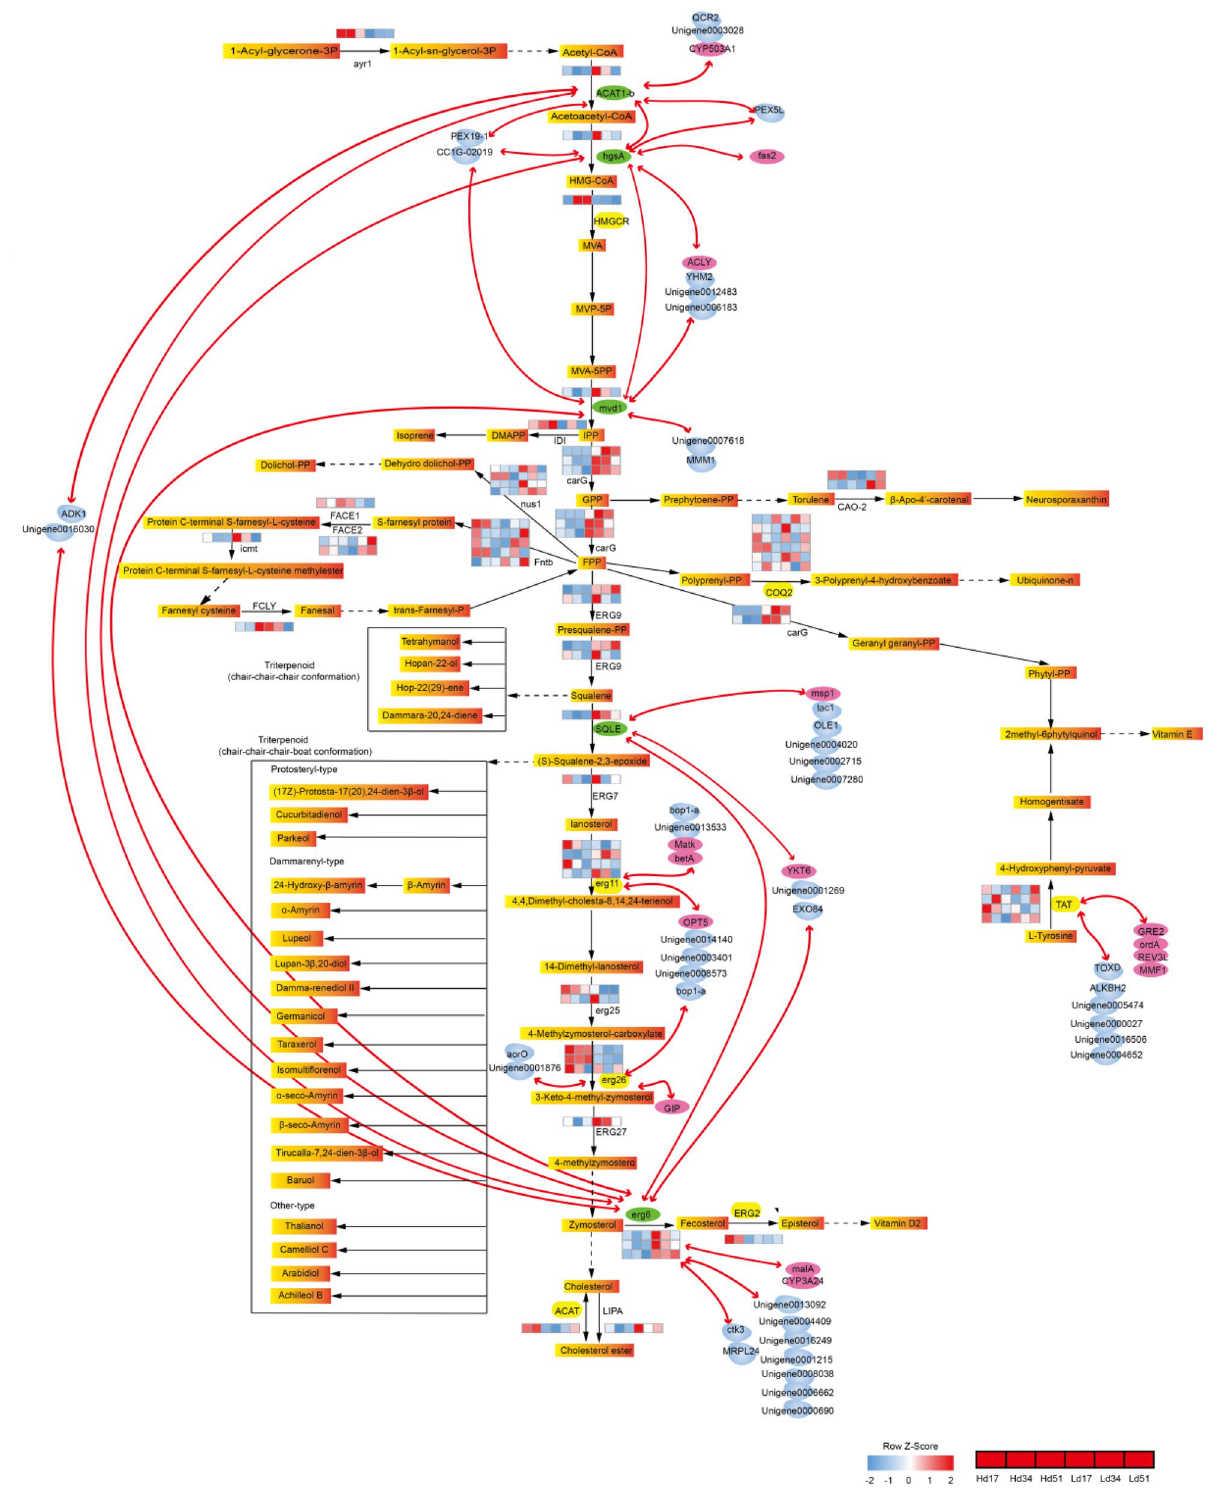
Figure 6. Illustration of the gene expression differences and relationships for triterpenoid-related genes in the two strains. Gradual orange rectangles represent the metabolite, enzyme abbreviation, and enzyme expression level for the three time points of the two strains marked on the bottom, left, or right of the arrow connecting two metabolites. Solid black arrows represent direct catalytic reactions, and dotted black arrows represent indirect catalytic reactions. Metabolites in solid black boxes are triterpene products of the same type catalyzed by different enzymes with the same precursor. Blue molecule shapes represent protease genes; purple elliptic traits represent regulators, marked with the gene abbreviation or ID. Red lines represent connecting correlations. The heat map of each gene’s reads per kilobase of transcript per million mapped reads (RPKM) value shows the standardized z-score. (Adobe Illustrator CS6: https:// www. adobe. com/ cn/ produ cts/ illus trator.